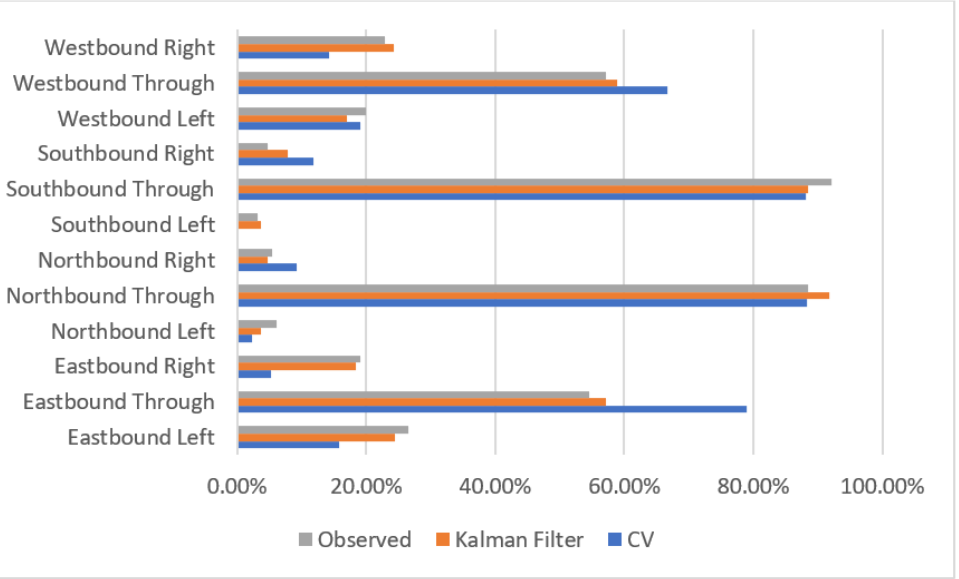
Figure 10. Comparison of CV, KF, and Observed TM Percentages for 7:30 – 9:30 a.m., 24 August 2021.